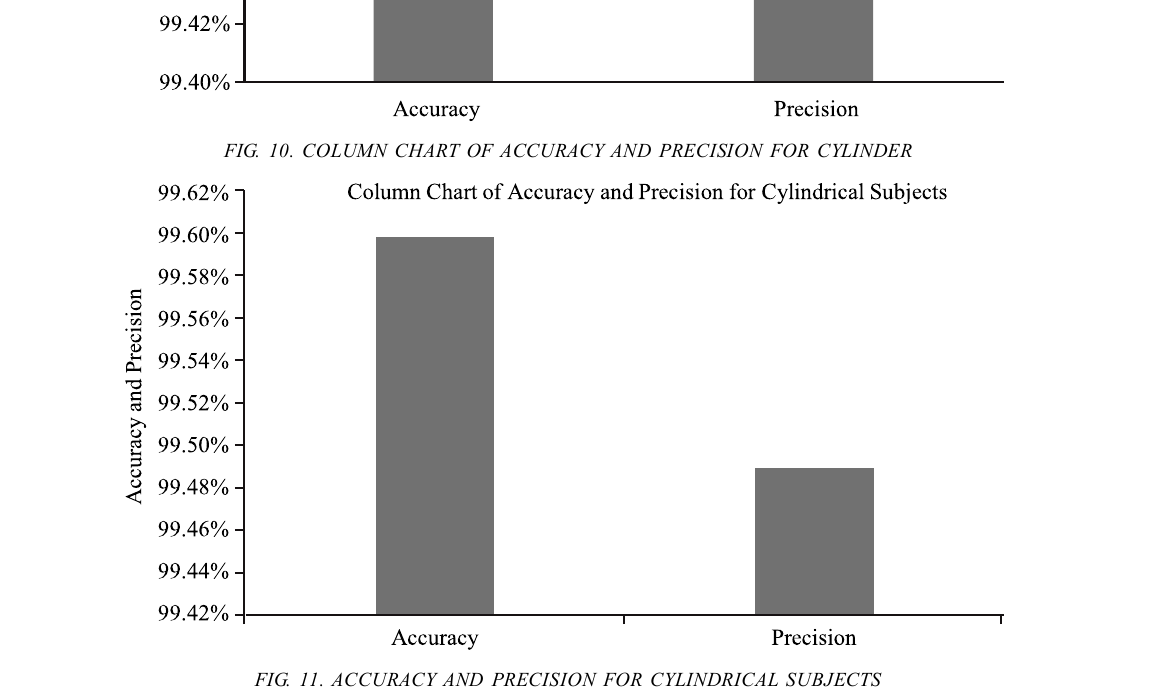
FIG. 11. ACCURACY AND PRECISION FOR CYLINDRICAL